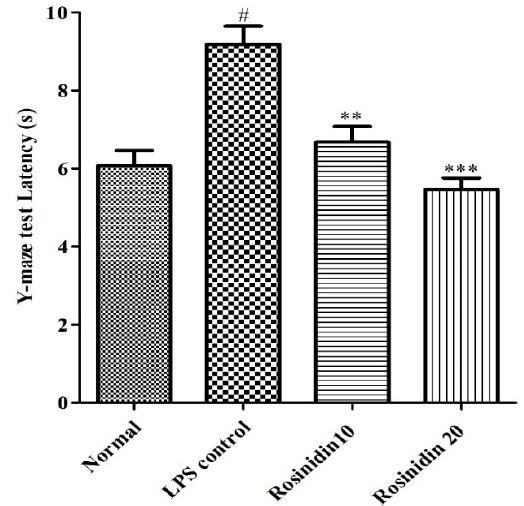
Figure 5. Effect of rosinidin on Y-maze test on LPS-treated rats. Values are expressed in mean ± S.E.M. (n = 8). # p < 0.05 vs. normal control rats and ** p < 0.01; and *** p < 0.001 vs. LPS control rats. One-way ANOVA followed by Tukey’s post hoc test.